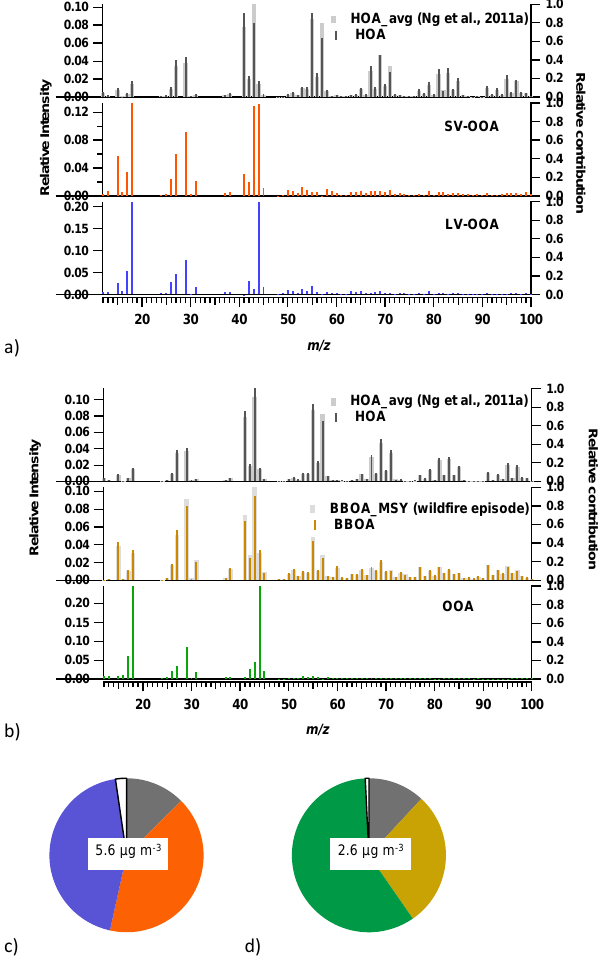
Figure 8. Mass spectral profiles of the organic sources identified for (a) summer and (b) winter. Average contribution of the organic sources to total OA for (c) summer and (d) winter. The white frac- tion of the pie charts corresponds to unexplained mass.